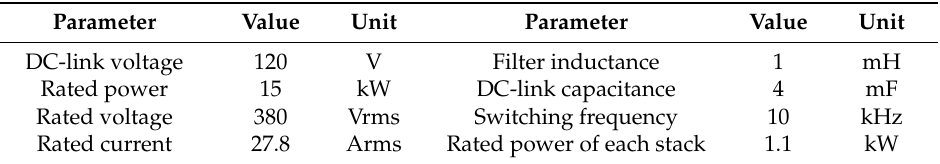
Table 1. Simulation and experiment parameters.